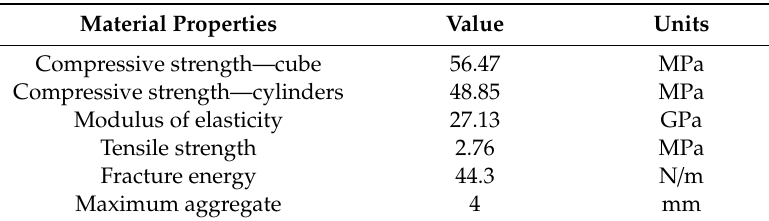
Figure 9. Load capacity of small reinforced concrete beams without transverse reinforcement: Experiments and inverse analysis results shown.